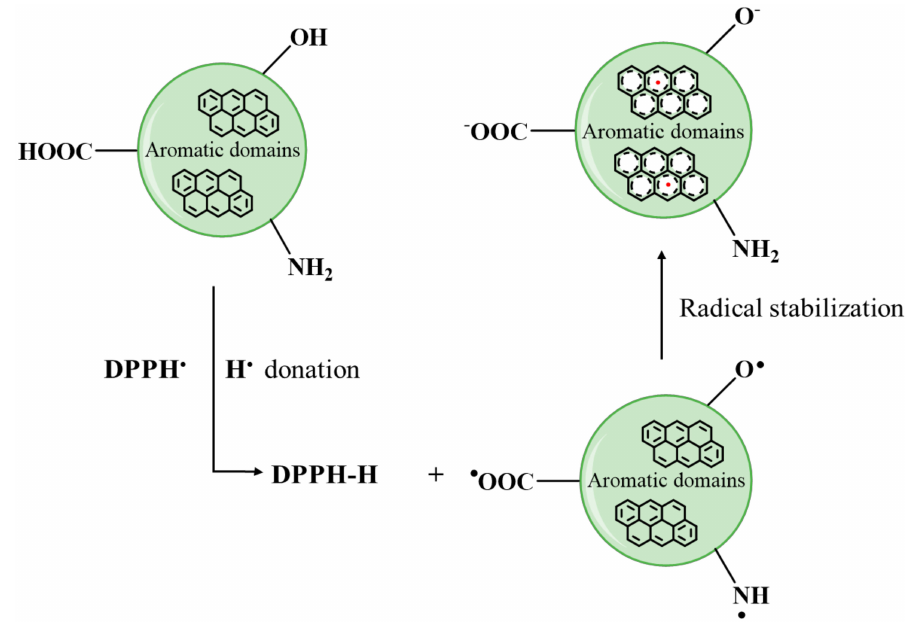
Figure 7. Mechanism of DPPH • reduction by antioxidant CDs in aqueous